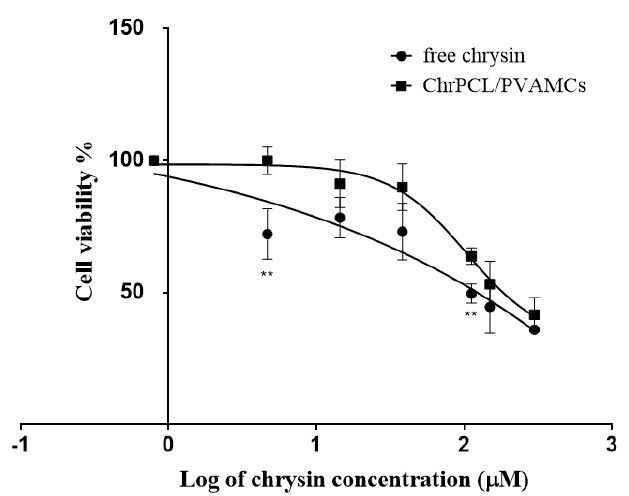
Figure 6. Cell viability (%) of MDA-MB-231 human breast cancer cells line exposed for 48 h to different concentrations (6.25, 12.5, 50, 100, 200 and 400 µ g · mL − 1 ) of ChrPCL/PVAMCs and to their corresponding equal molar concentrations of free chrysin. Cell viability was assessed using the MTT assay. The inhibitory concentration of chrysin for 50% viability (IC 50 ) in MDA-MB-231 cells is 111.89 µ M for free chrysin and 149.19 µ M for ChrPCL/PVAMCs (encapsulated chrysin in the PCL/PVAMCs) ** p < 0.01.